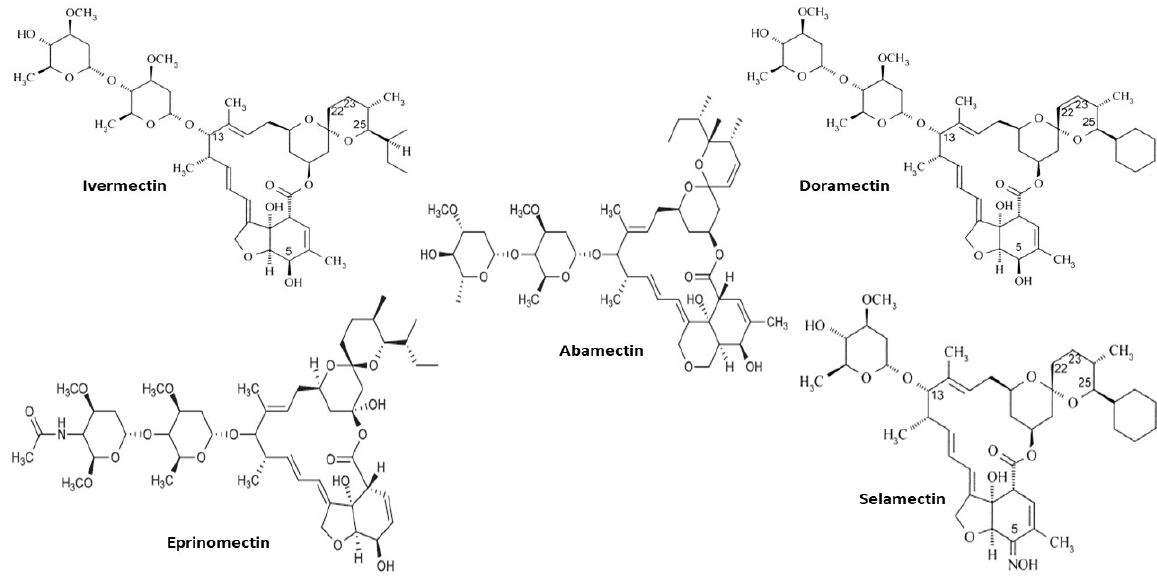
Figure 2. Chemical structure of various avermectins.